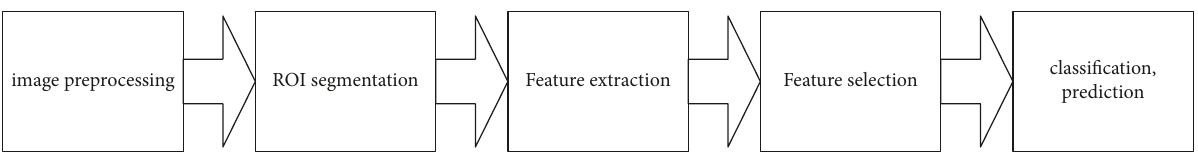
Figure 2: The basic framework of the auxiliary diagnosis method of Alzheimer’s disease based on